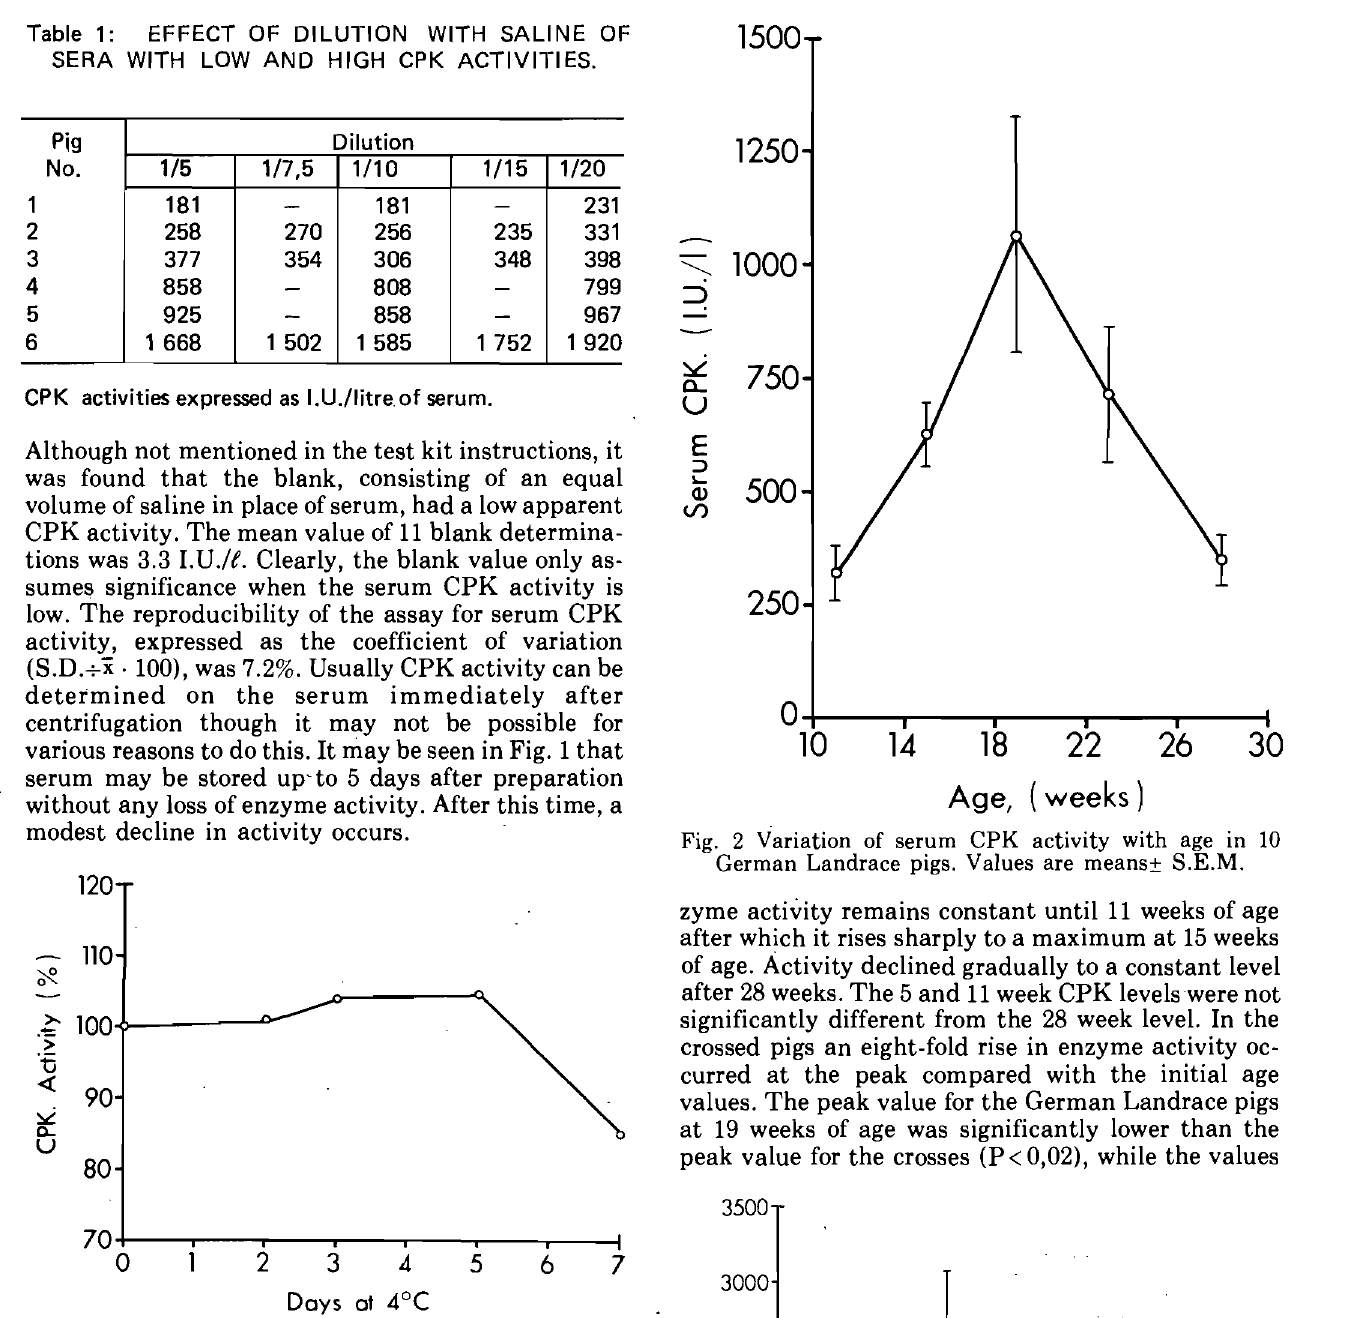
Fig. 1 Stability of serum CPK activity stored for up to 7 days at 4°C. The values, expressed as a percentage of initial values, are means for six animals.